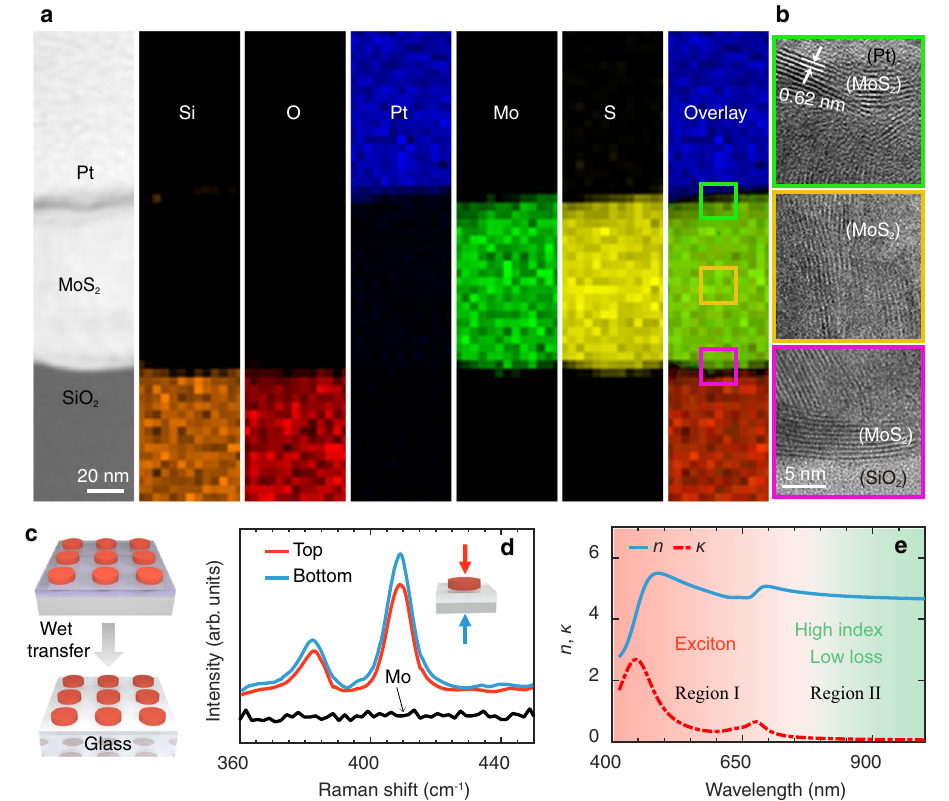
Fig. 2 | Structural and material characterizations of MoS 2 pattern. a Cross- sectional low magni fi cation view (left 1) of scanning transmission electron micro- scopy (STEM) micrograph of the MoS 2 grating for elemental mapping. Corre- sponding energy dispersive X-ray spectroscopy (EDS) maps of the MoS 2 cross- section show the spatial distributions of elements Si, O, Pt, Mo, S, and overlay separately. b High-resolutiontransmissionelectronmicroscopy(HRTEM)graphsof the top boundary (green box), internal part (yellow box), and bottom boundary (magentabox)ofthe MoS 2 bar. c Schematicofthe transferring procedureof MoS 2